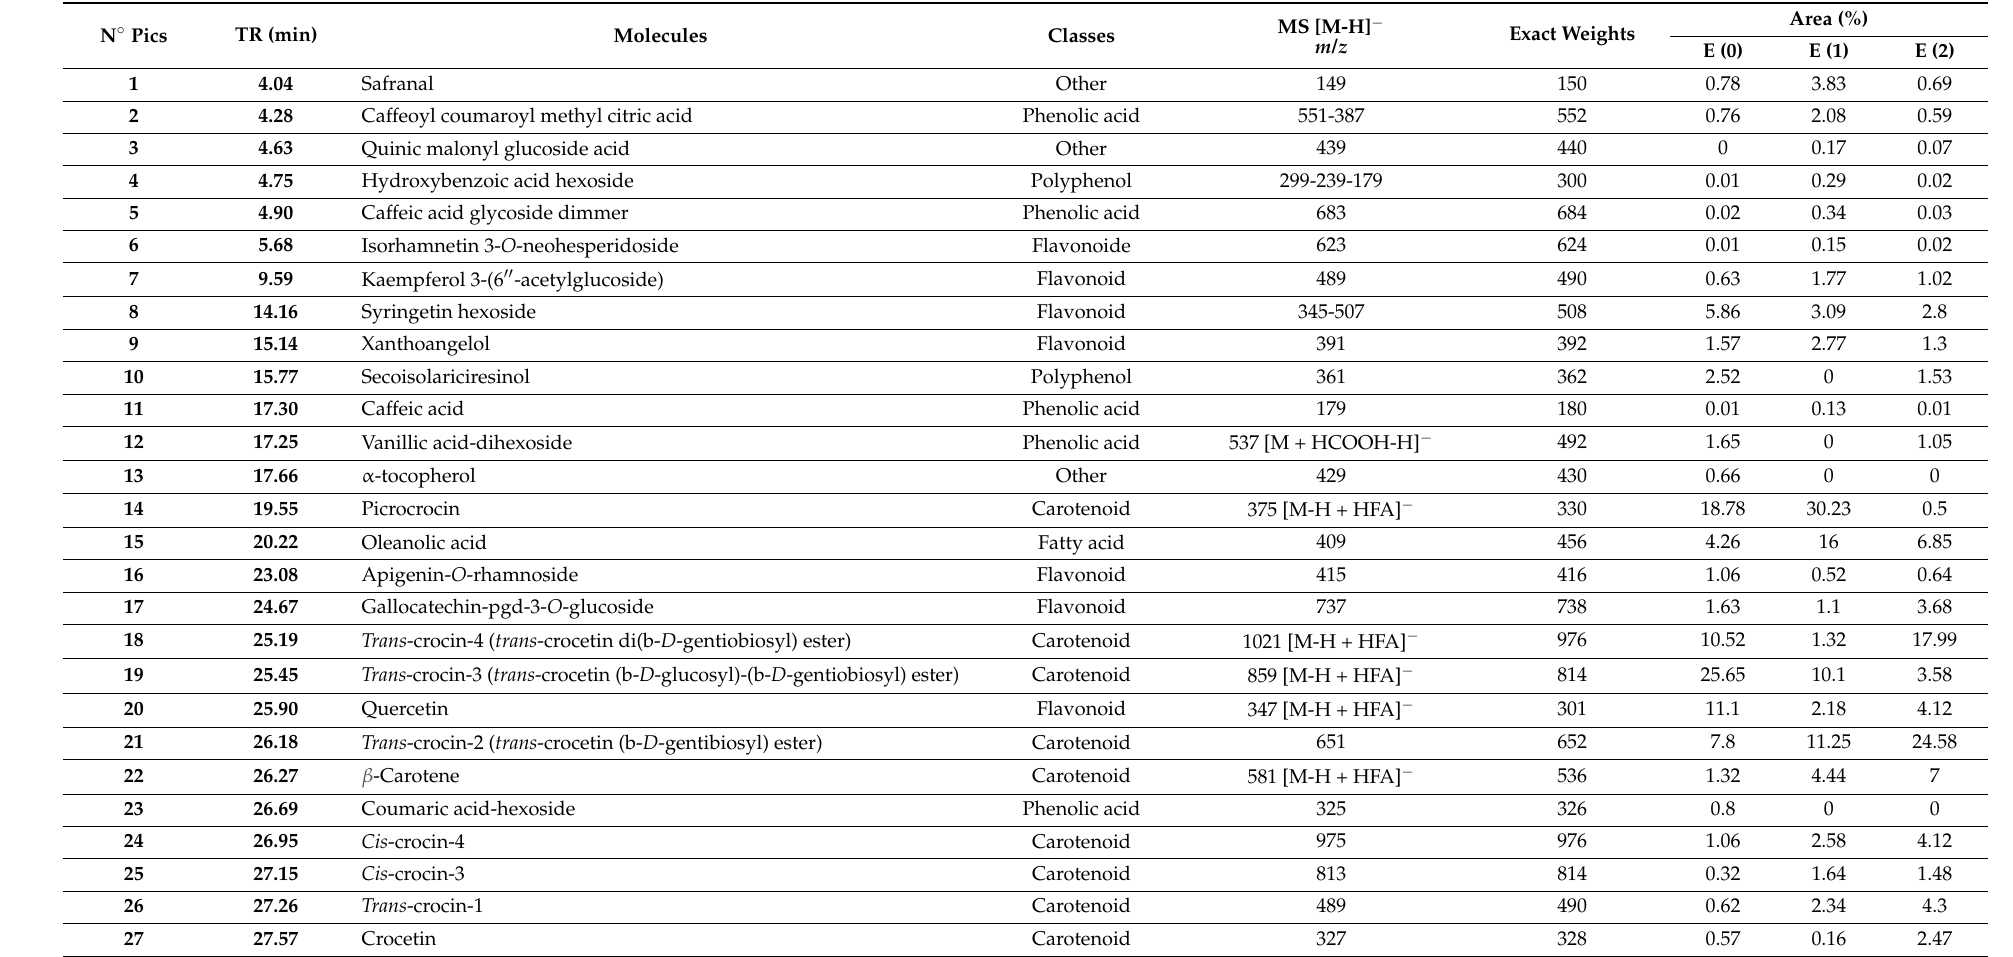
Table 4. List of compounds identified by mass spectrometry in the stigmas of C. sativus